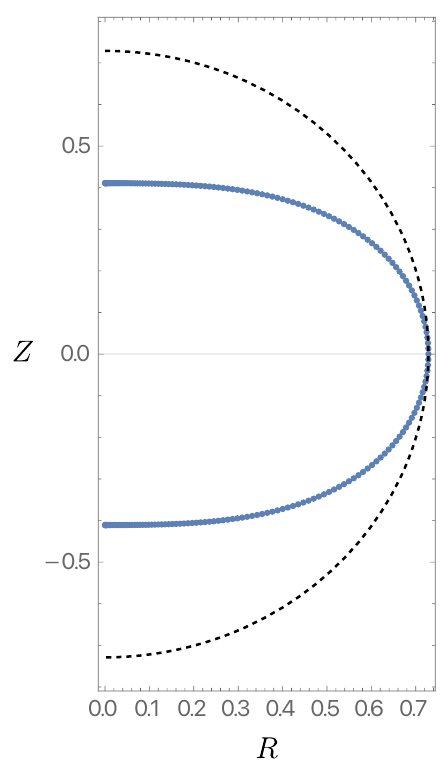
Figure 5 . Isometric embedding of the near horizon geometry into R 4 . The black dashed line shows what a perfect sphere would look like and the blue disks represent our novel pancaked IR geometry. This particular embedding was generated for G 5 Q/L 2 ≈ 1 . 61 .